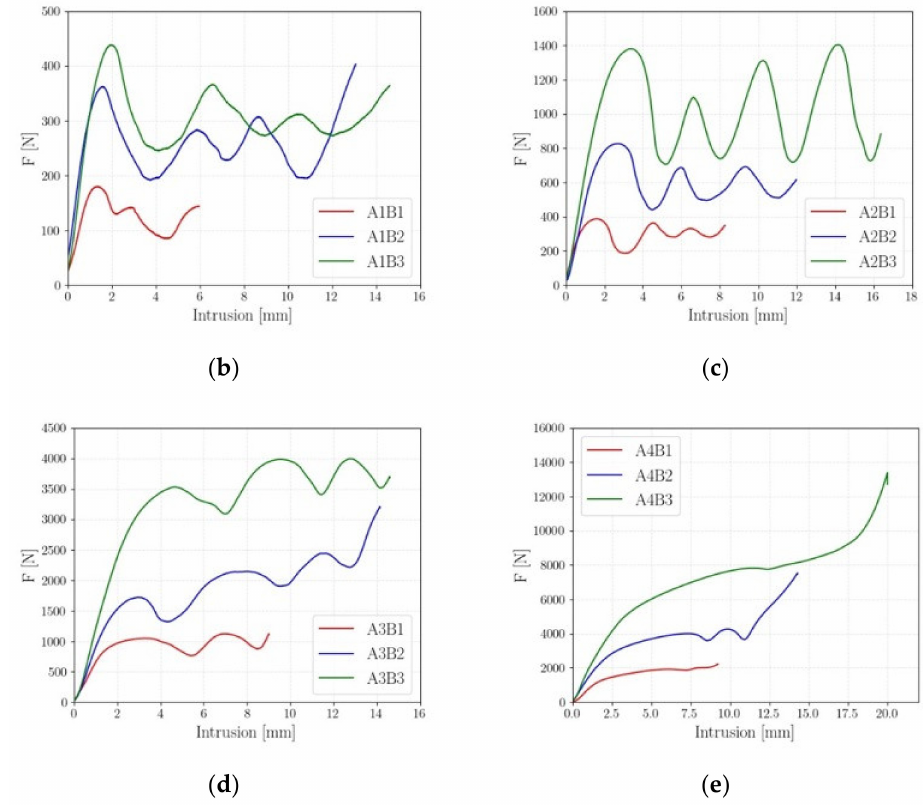
Figure 7. Experimental force–displacement curves for FP2 : ( a ) one representative curve for each specimen condition; ( b ) force–displacement curves for d = 0.9 mm; ( c ) force–displacement curves for d = 1.2 mm; ( d ) force–displacement curves for d = 1.5 mm; ( e ) force–displacement curves for d = 1.8